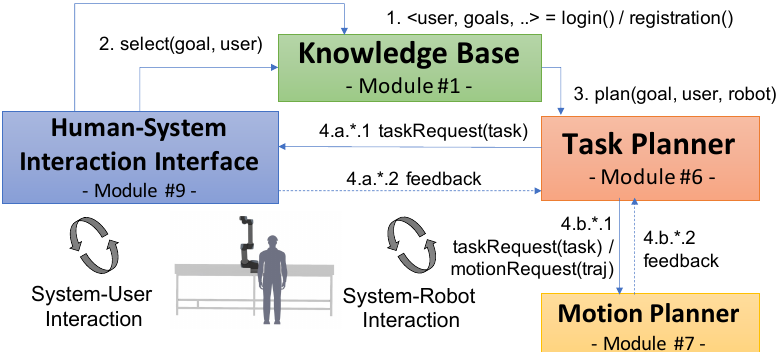
Figure 2. Integration schema of the considered modules. First a user logs into the system through the “Human-System Interaction Interface” and selects a production goal to perform (step 1 and